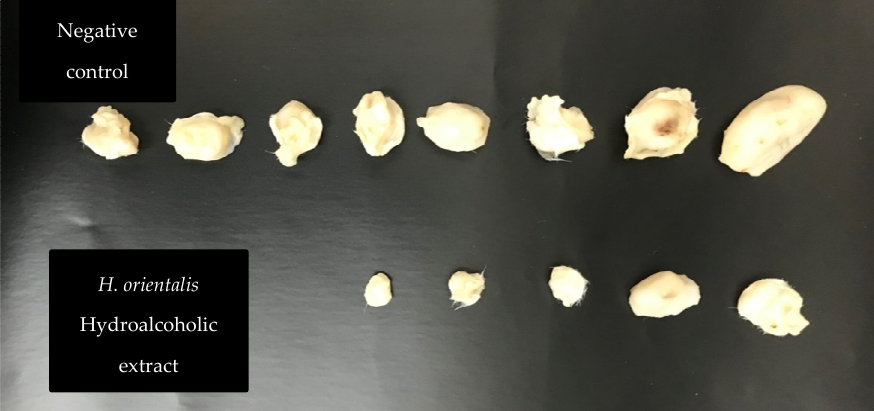
Figure 9. Effect of H. orientalis L. hydroalcoholic extract on tumor size and cure percentage. Treatment with H. orientalis resulted in smaller tumors size and higher cure percentage compared to the negative control ( n = 10 mice in each group).